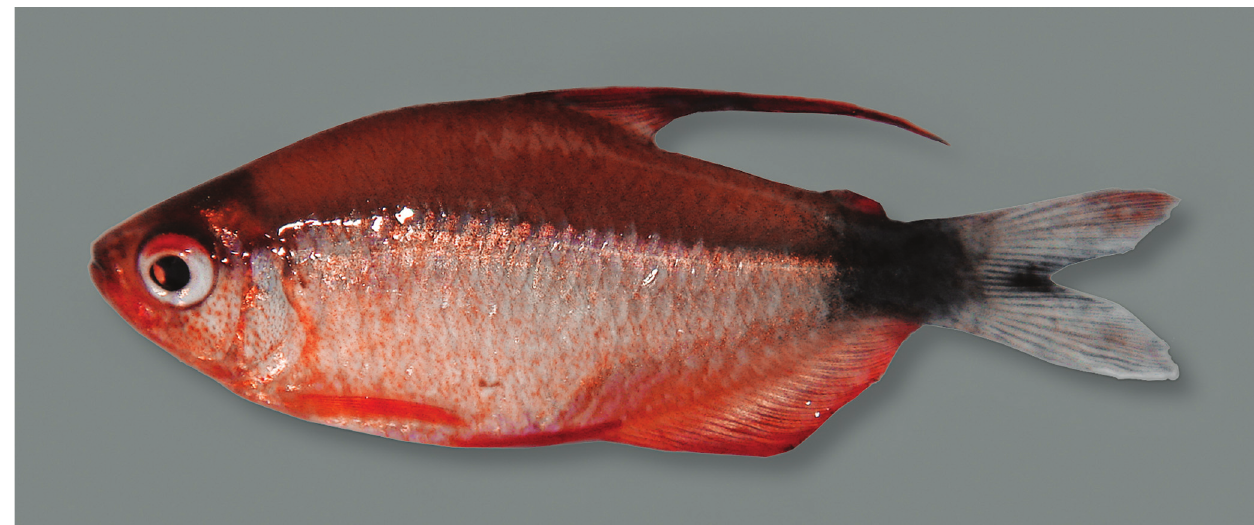
Fig. 4. Hyphessobrycon peugeoti , new species, holotype, MNRJ 38988, 38.5 mm SL, male, Brazil, Mato Grosso State, Cotriguaçu, tributary of rio Juruena, immediately before fixation.